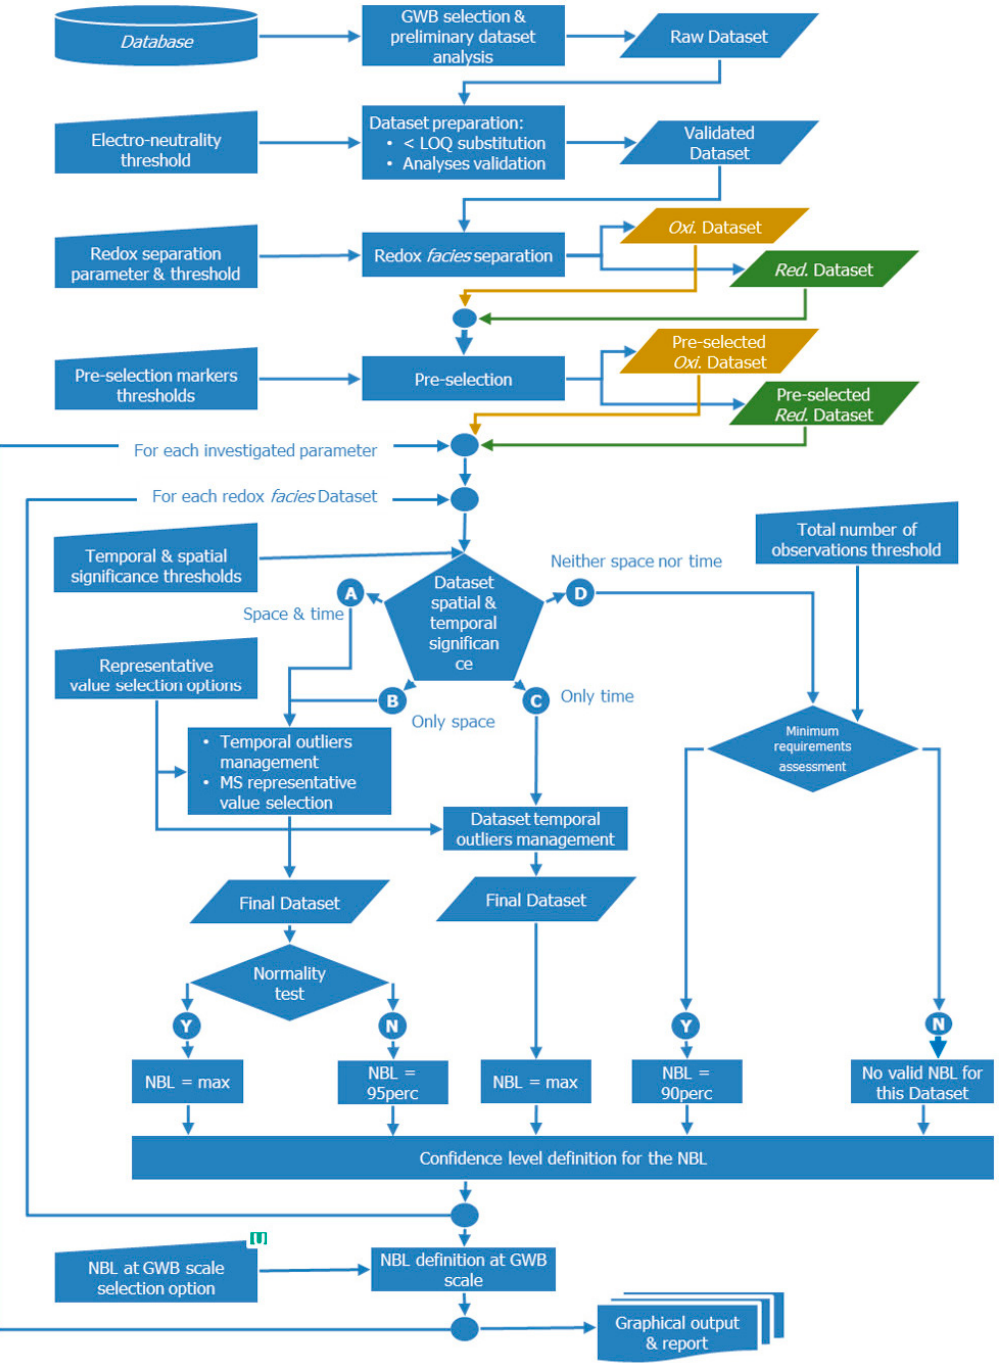
Figure 2. General scheme of the evaluation of natural background levels (eNaBLe) tool.